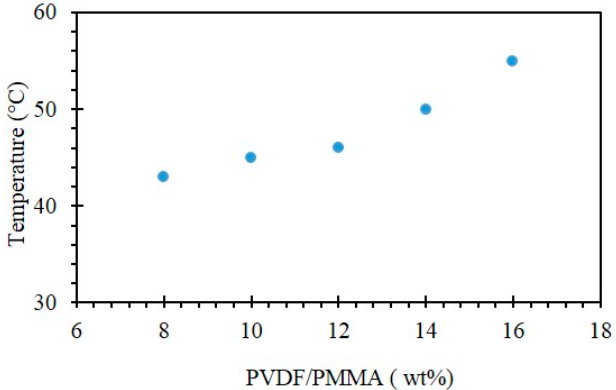
Figure 2. Sol-gel transition temperature for different concentrations of PVDF/PMMA (poly (vinylidene fluoride/poly (methylmethacrylate)).